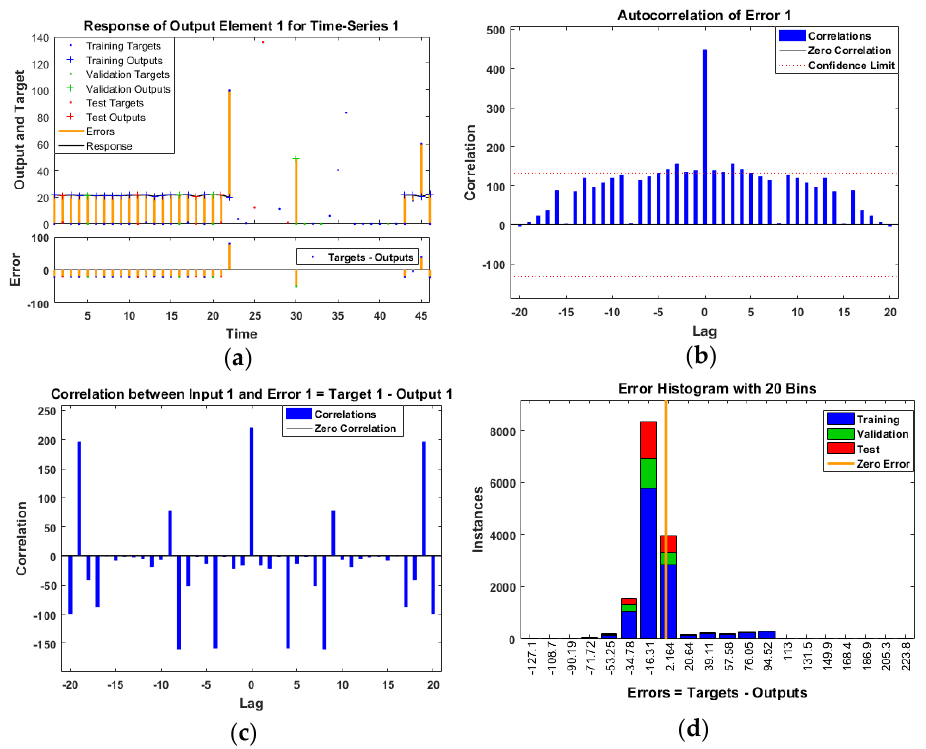
Figure 3. Performance of the neural network: ( a ) input error correlation, ( b ) error autocorrelation, ( c ) correlation plot response, and ( d ) error